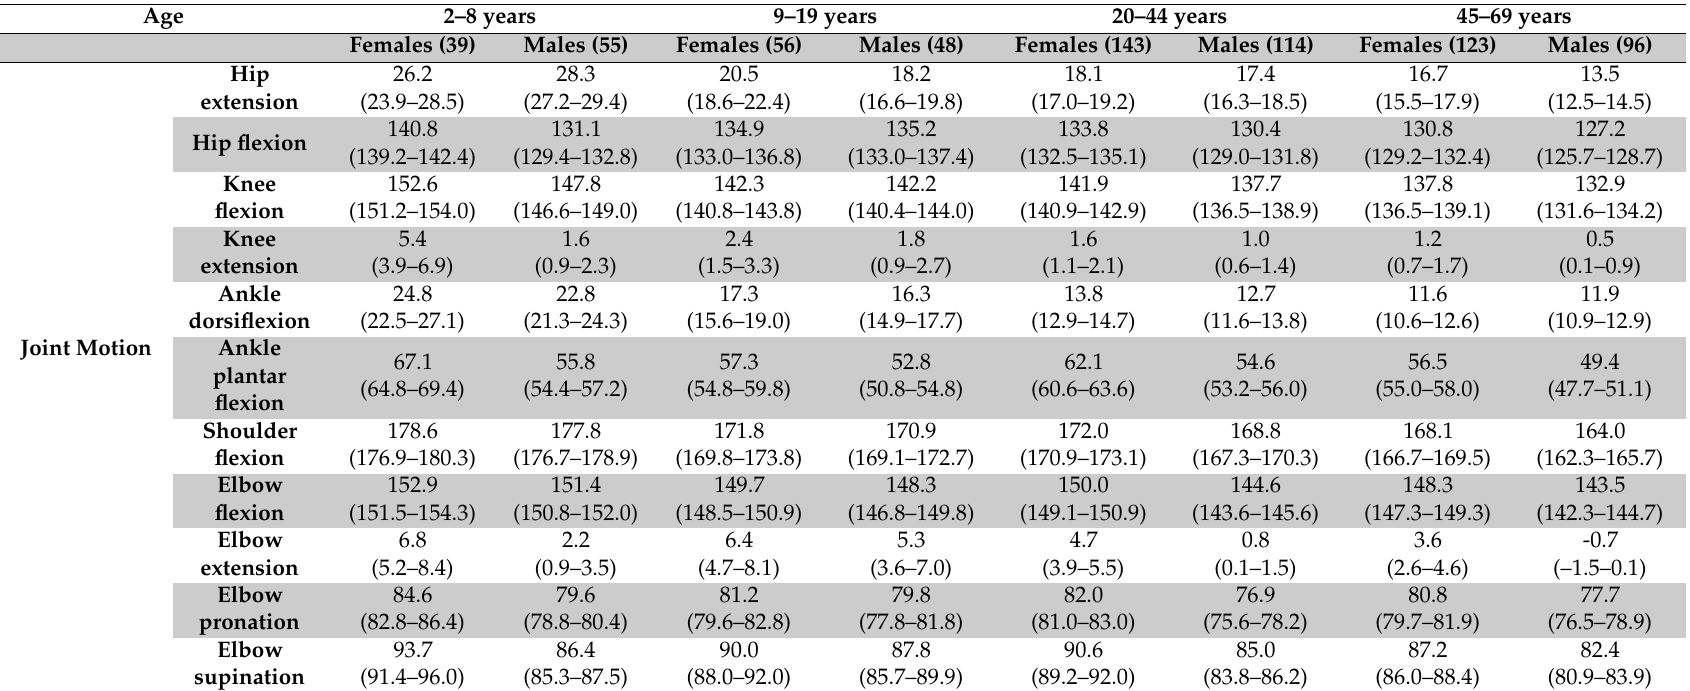
Table 3. Active range of motion (ROM) ( ◦ ) for human joints by gender and age